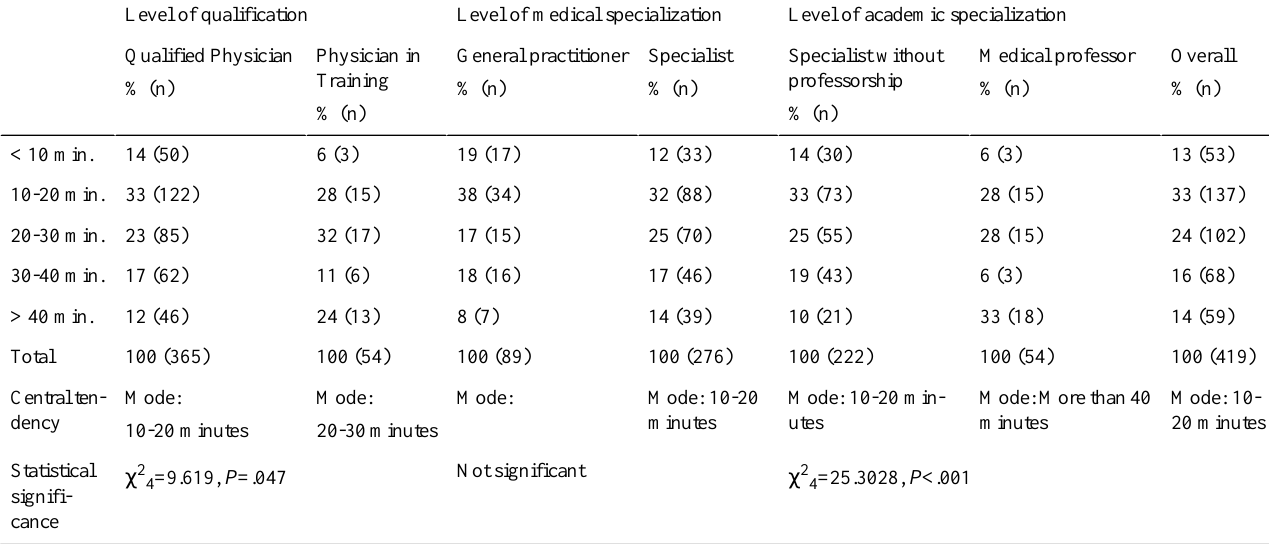
Table 3. Time that physicians report having for answering complex questions (question: “How much time can you or are you generally willing to spend on trying to find the answer to an important, complex clinical